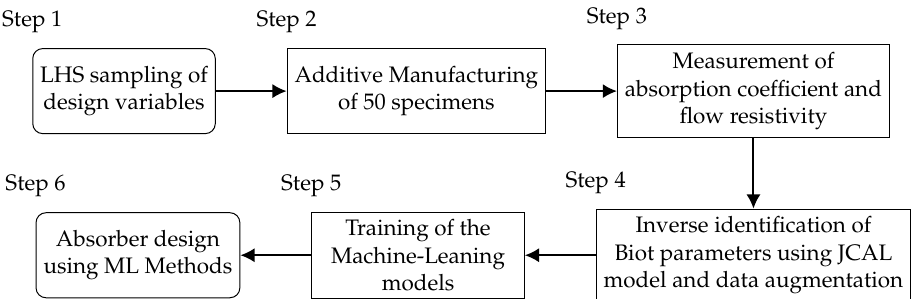
Figure 1. General procedure of the work to obtain ML models that predict Biot parameters from specimen geometry and their application to absorber